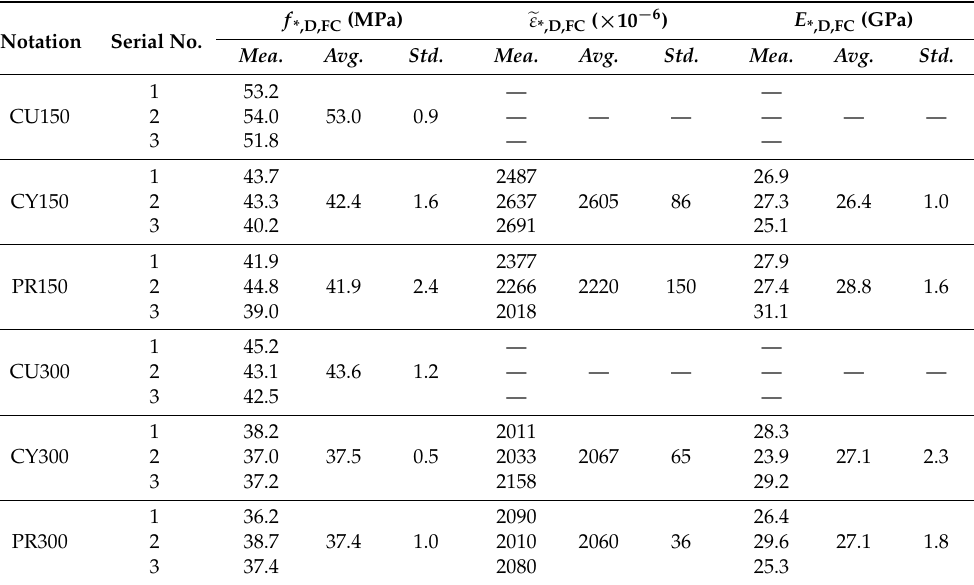
Table 3. Experimental results of specimens in Group